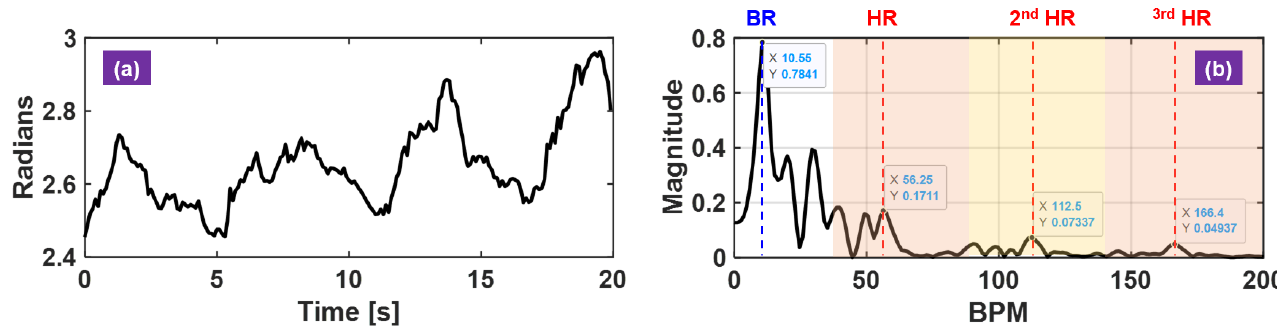
Figure 4. Spectral-based heart-rate (HR) and breathing rate (BR) calculation. ( a ) raw Doppler phase from single radar measurement dominated by breathing motion; ( b ) the corresponding complex vital-sign spectrum with the most relevant spectral features labeled with help of breathing and pulse references. The shaped areas denote the frequency region of the fundamental HR and HR